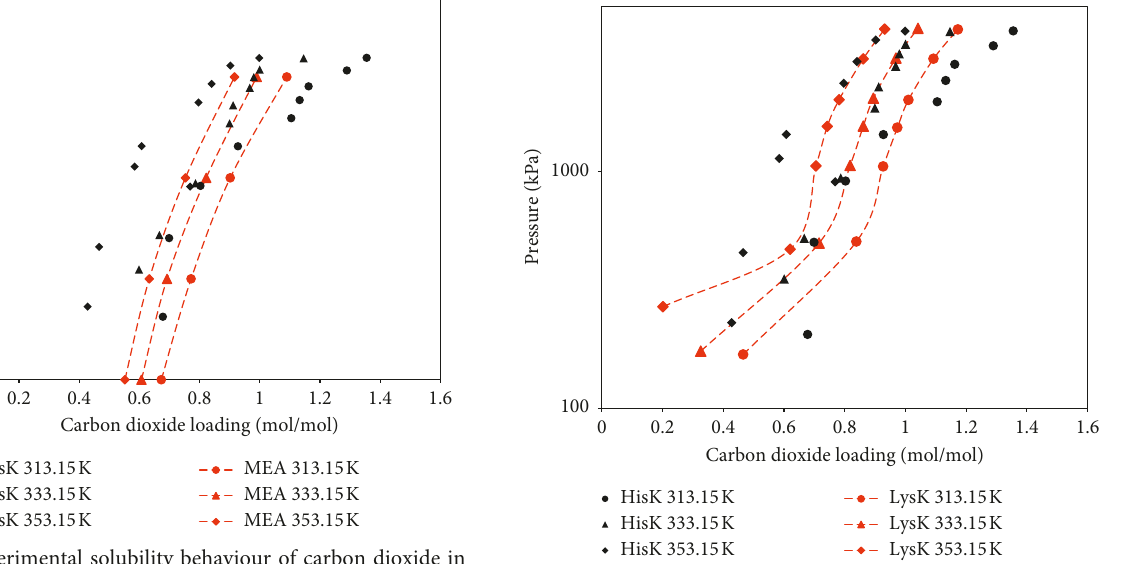
Figure 5: Experimental solubility behaviour of carbon dioxide in 2.5 M aqueous potassium salt of L -histidine and data of 2.5M aqueous potassium salt of lysinate